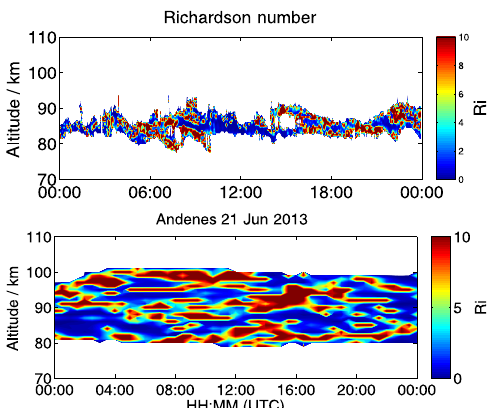
Figure 5. Richardson number estimated from the vertical wind shear and Brunt–Väisälä frequency. The Richardson numbers were calculated from the vertical wind shear and the Brunt–Väisälä fre- quency assuming a NRLMSISE-00 background temperature profile shifted by 10K to lower